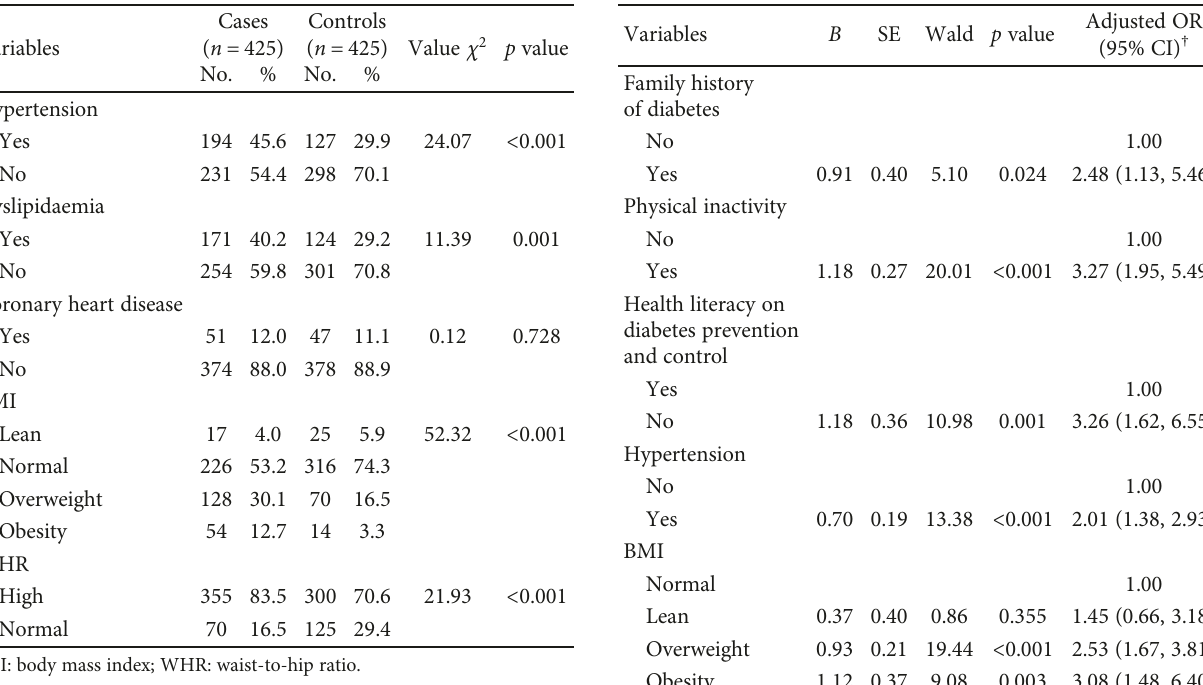
Table 4: Multivariate logistic analysis of the risk factors for prediabetes among the elderly.